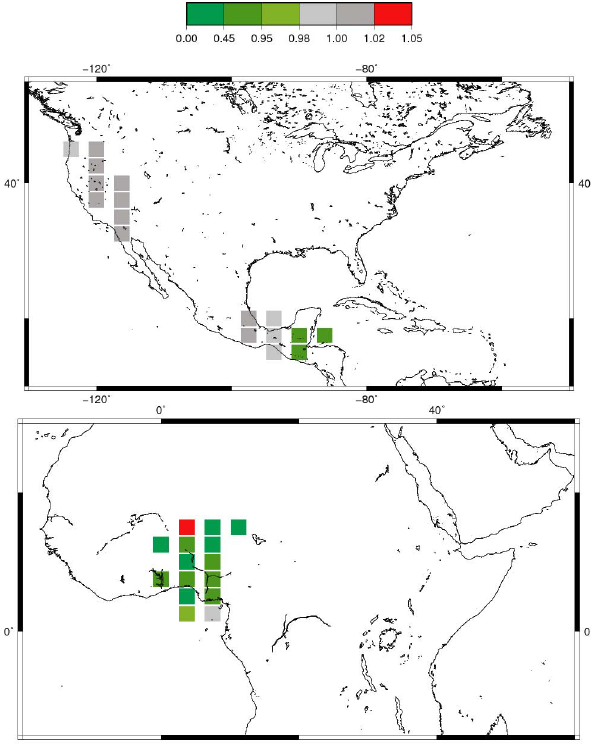
Fig. 6. Ratio of the posterior to the prior values of bias (in abso- lute value) between simulated and observed concentrations for the INTEX-B (top) and AMMA campaigns (bottom). The inversion im- proves the simulation when the ratio of the absolute bias is less than 1 (in